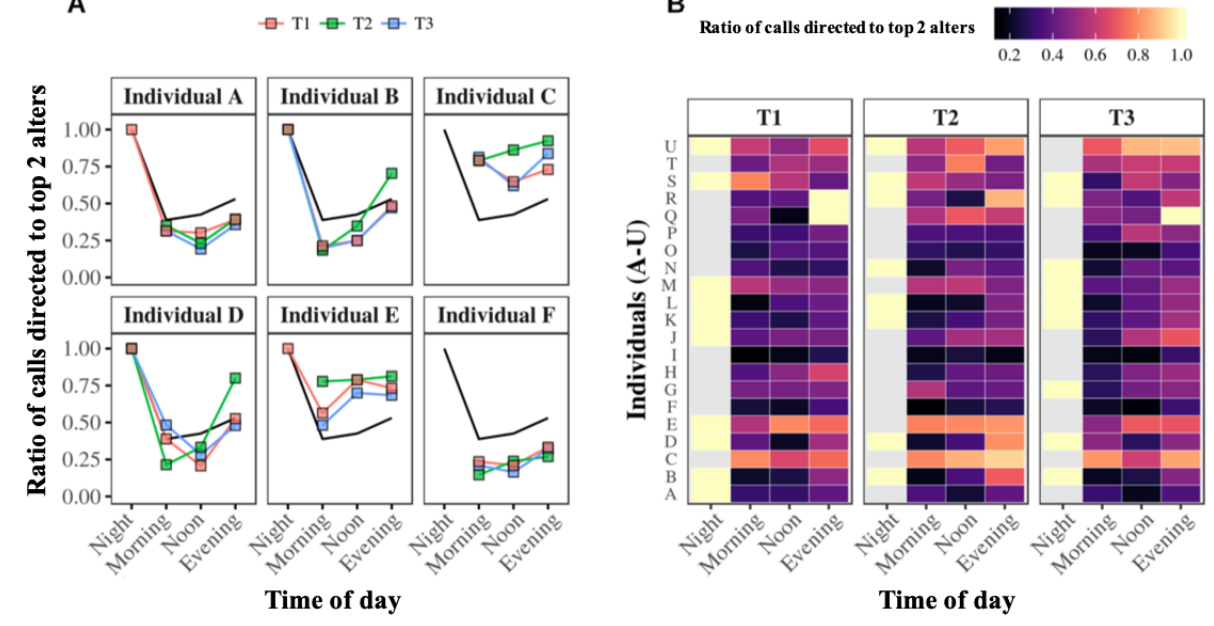
Figure 6. Fraction of outgoing telephone calls to top 2 alters at the individual level. Panel A. Each graph displays one participant’s fraction of calls to their top 2 alters during the night, morning, afternoon, and evening, calculated for periods T1 (red curve), T2 (green curve), and T3 (blue curve). The black curve represents the average fraction of calls to the top 2 alters of the entire population over the three periods. Panel B. These heat maps summarize the fractions of outgoing telephone calls going to the top 2 alters of each of the 21 egos. High fractions are assigned brighter colors, whereas low fractions of calls are assigned darker colora. Missing values are assigned the color grey.